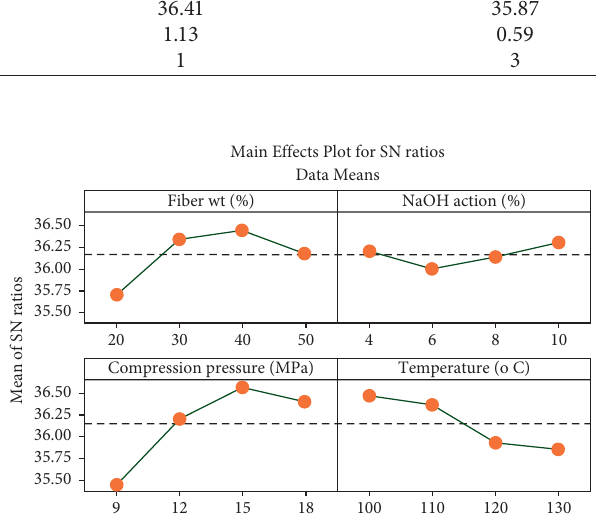
Figure 19: Main effect plot for means to shore D hardness. Figure 20: Main effect plot for S/N ratio to shore D